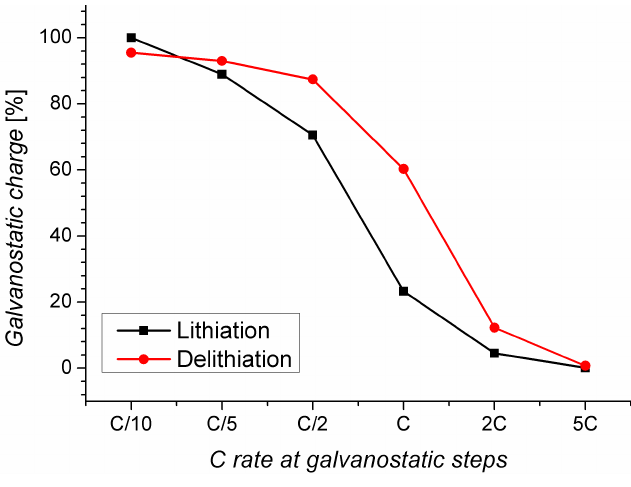
Figure 5. Proportion of the average charge obtained under the galvanostatic steps at different C rates when cycling under the galvanostatic/potentiostatic mode.